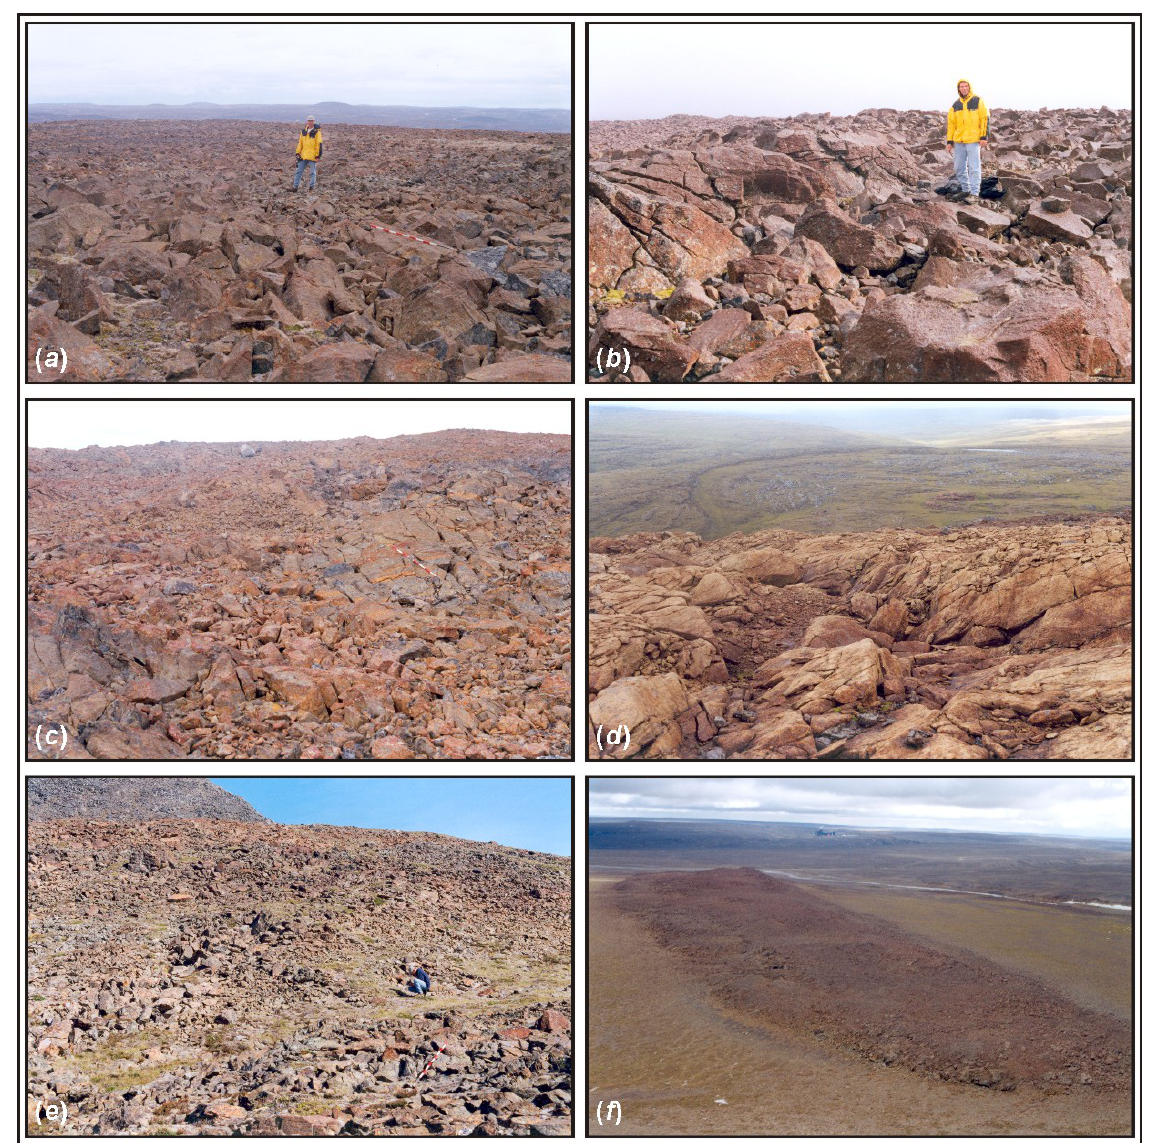
Figure 5. Peridotite units generally form distinct topographic features in the study area. Though fresh peridotite surfaces are mainly green to dark gray in the study area, exposed surfaces generally weather to orange or brown. ( a – e ) Ground views of prominent exposures of peridotite. ( f ) Low-elevation aerial view of a 3-km-long peridotite mound exposed in the southeastern part of the study area. Site locations are given in Figure